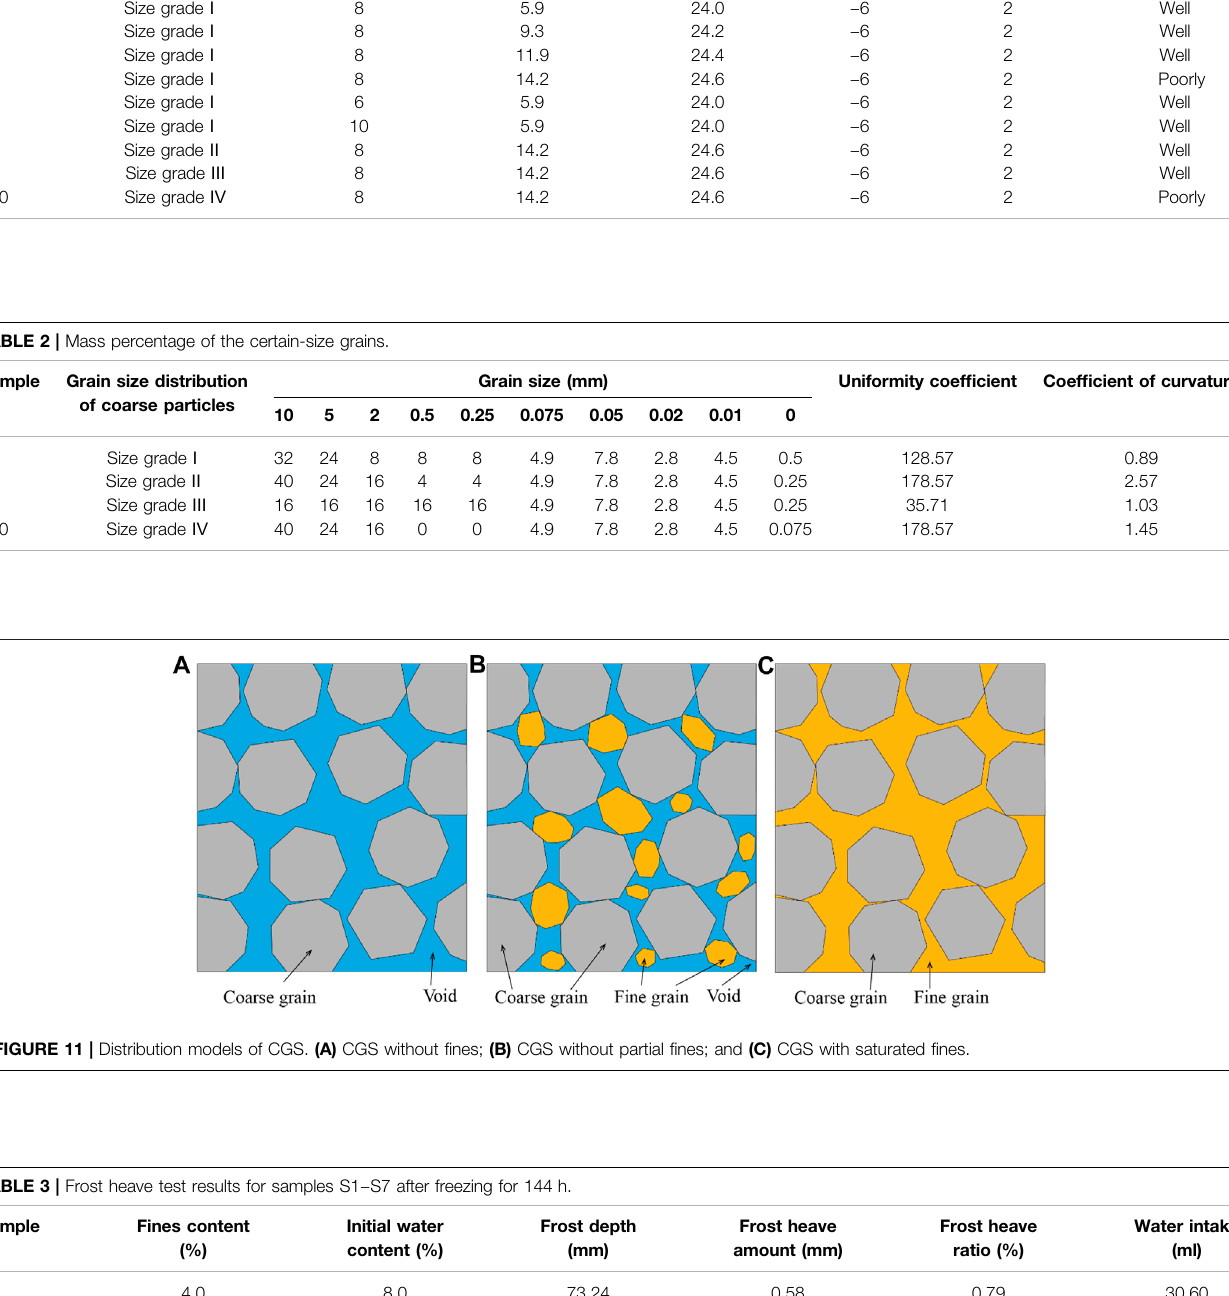
TABLE 1 | Frost heave test schemes for CGS fi llings. Sample